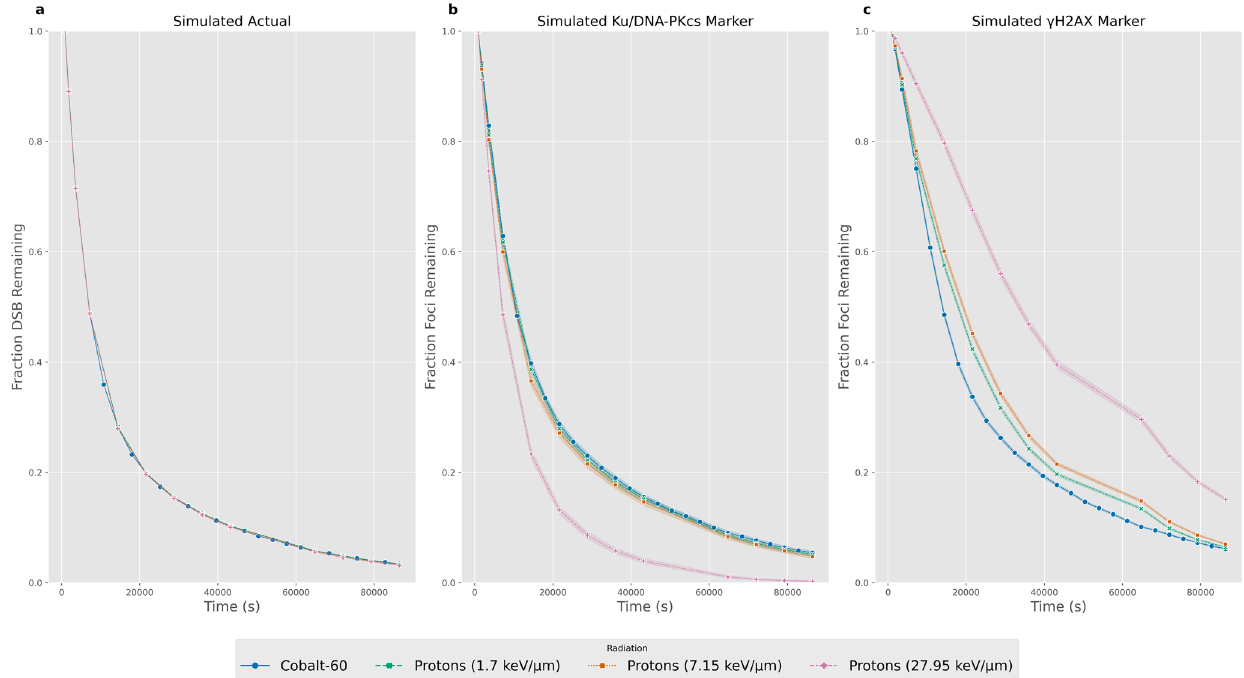
Fig. 3 Repair kinetics comparison between virtual cells irradiated with four different incident radiation conditions. The fraction of DSB/Foci remaining have been normalised to the 15 min time point to allow comparison of repair kinetics regardless of the total number of DSB breaks induced. a shows the repair kinetics of the actual number of DSBs within the evaluated microscope slice. The repair kinetics applied using the bi-exponential repair model is kept constant across all radiation types to separate out the impact of miscounting alone. b The repair kinetics when calculated from the foci detected in the Ku/DNA-PKcs marker microscope images. c The repair kinetics when calculated from the foci detected in the γ -H2AX marker microscope images. All microscope images have been emulated using the Airyscan ×63 and the results shown are for 2 Gy of radiation. Error bars are shown as banding and corresponds to the 95% con fi dence interval.